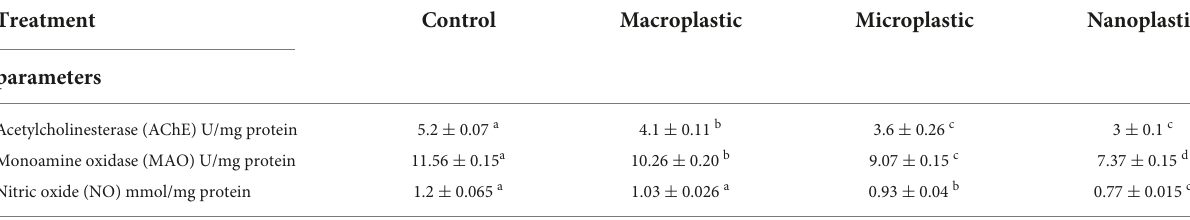
TABLE 1 Effect of (macro-, micro-, and nano) plastics exposure for 15 days on neurological biochemical endpoints of the Common carp ( Cyprinus carpio L .).